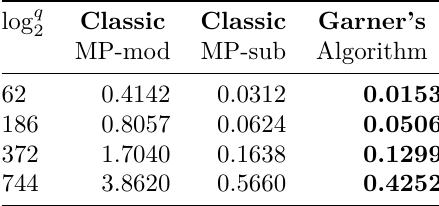
Table 2: Latency in (millisecond) of reconstructing a polynomial of degree < ( n = 8192) with coefficients of size log q on Tesla K80 NVIDIA GPU card averaged over 10000 2